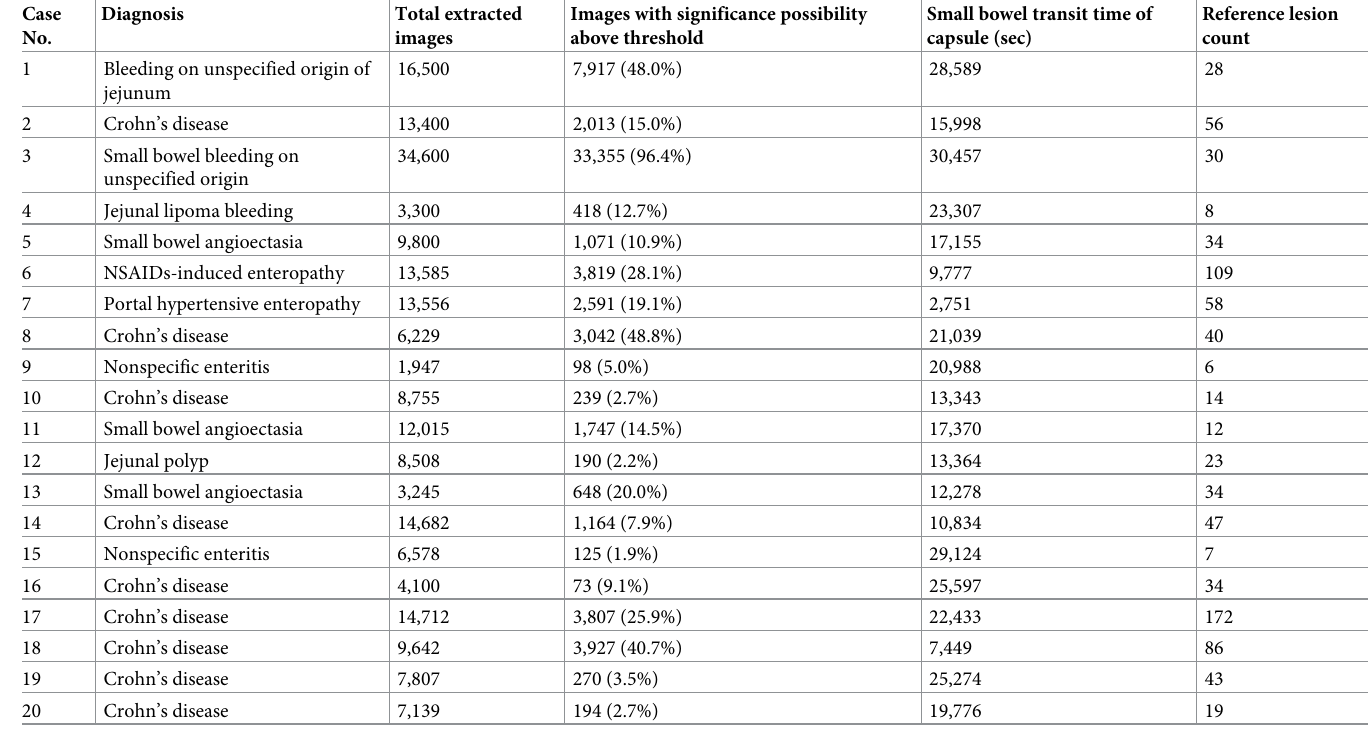
Table 2. Clinical characteristics of cases and summary result of